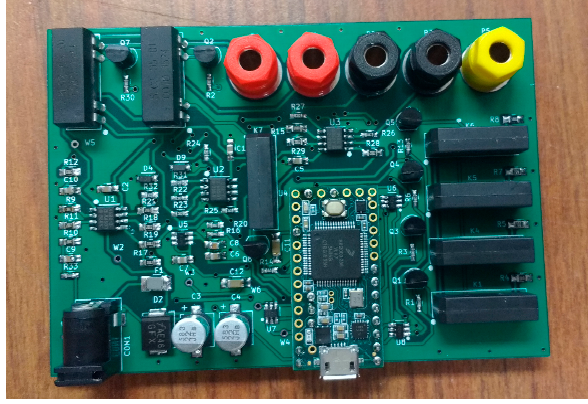
Figure 8. Assembled open source printed circuit board for four-point probe measurements.